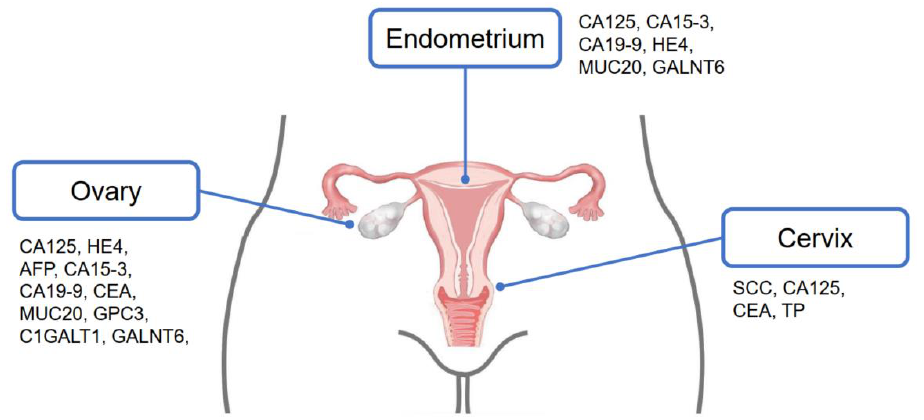
Figure 2. FDA-approved and potential new biomarkers of gynecologic cancers.